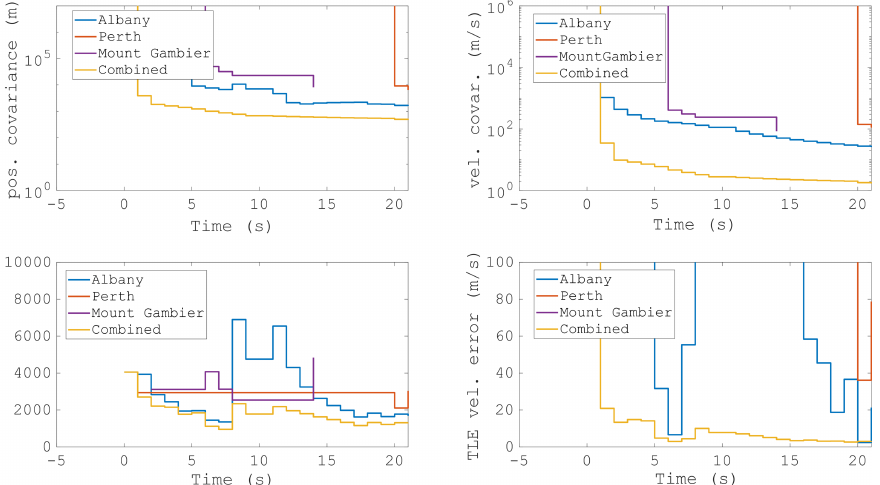
Figure 21. The resulting orbit predictions from the multistatic measurements from Figure 20. The top panels show the covariance of the position estimate and the velocity estimate. The bottom panels show the mean errors when compared with the two-line element